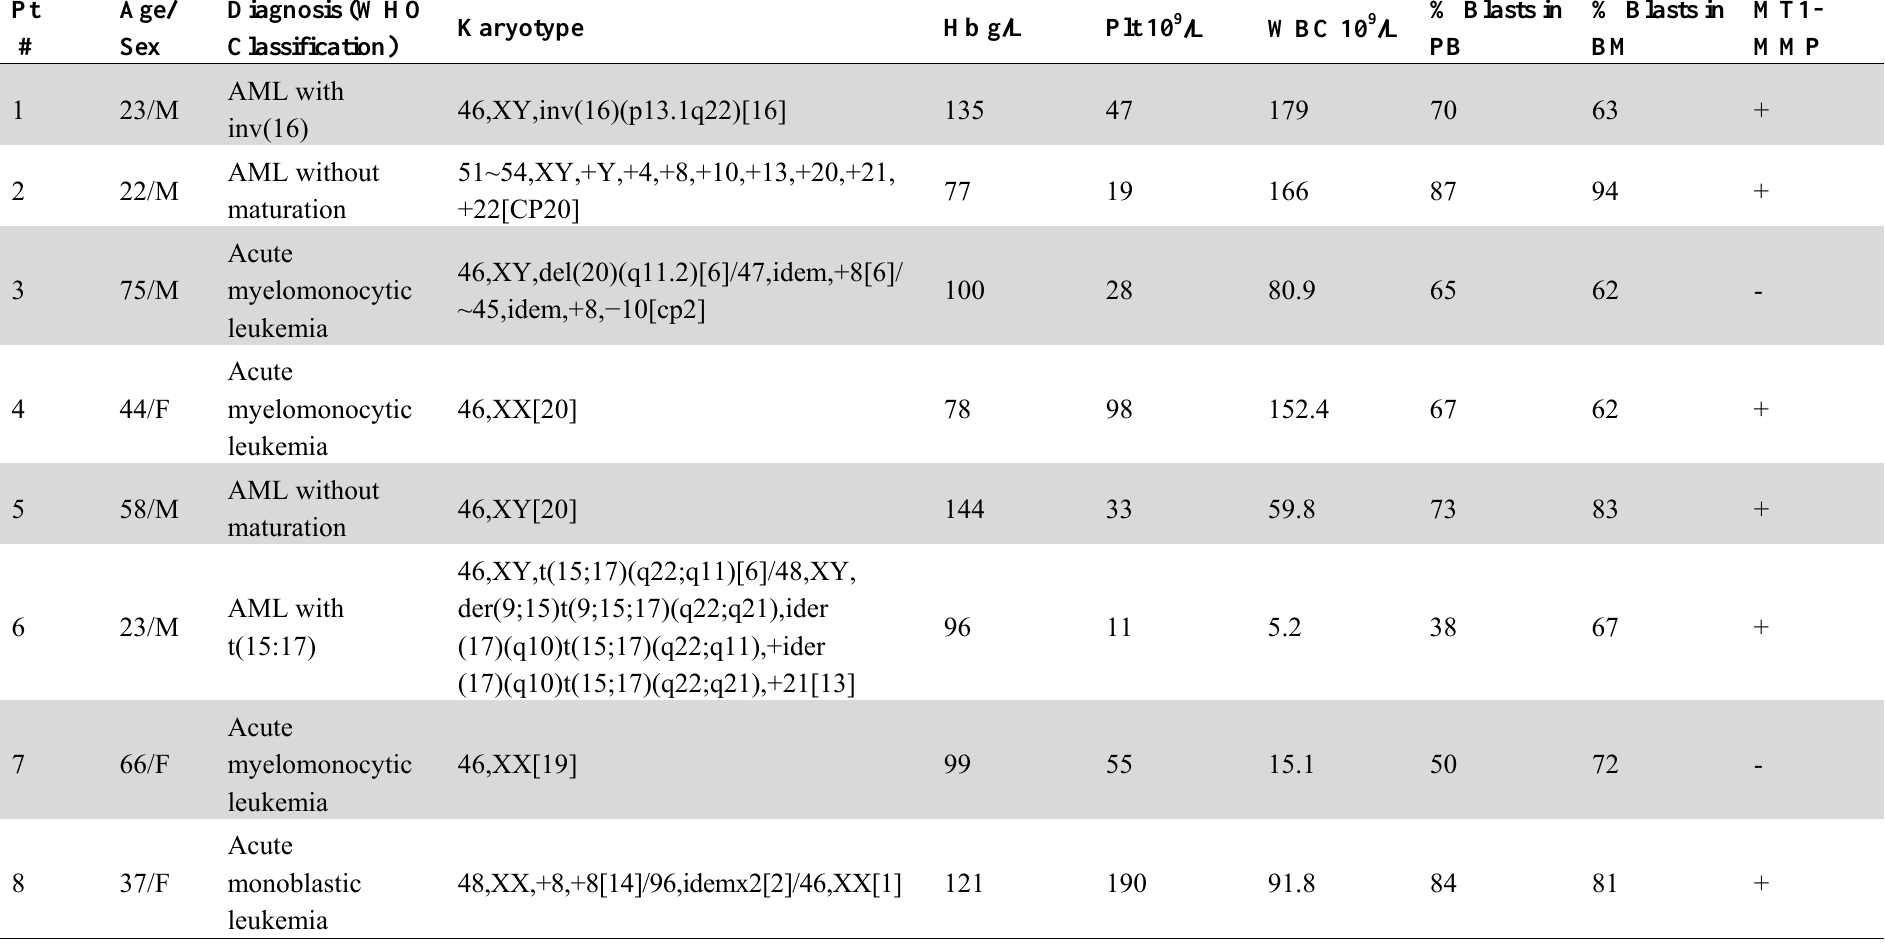
Table 1. Clinical characteristics of AML